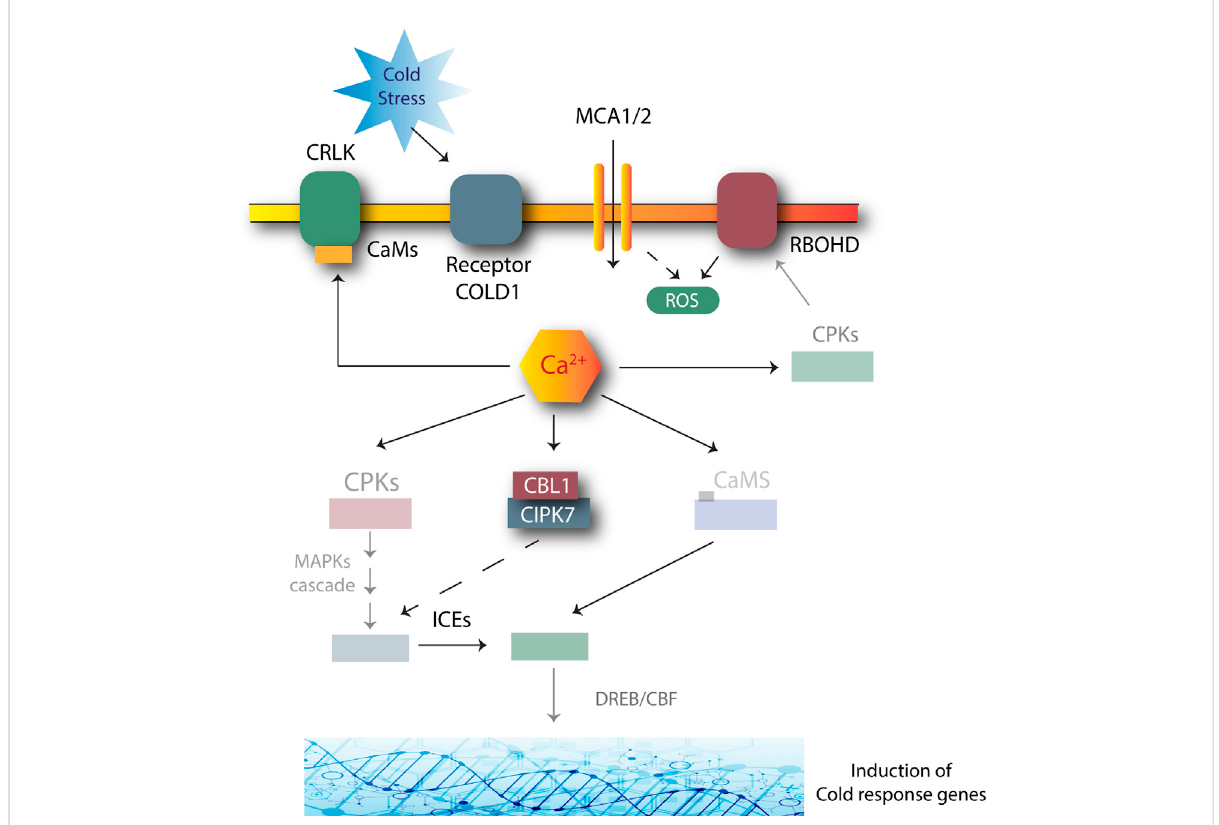
FIGURE 3 Role of CIPK-CBL complexes in managing cold stress in Arabidopsis. Many genes are involved in this response. Cold stress is fi rst perceived by COLD1 receptors. The signals activate the secondary Ca 2+ messengers. The transient changes produced in a cell due to Ca 2+ activation and AtSRC2 produce ROS due to the NADPH oxidase activity of the AtRBOHF. Increased ROS production positively regulates the Ca 2+ channels. CBL1- CIPK playsarolebyphosphorylating andactivating theMAPK cascades. CRLK1 orCRLK2interactswith calmodulin (CaM) tofurtheractivate the MAPK cascade. The MAPK pathway suppresses the breakdown of ICE1 to tolerate stress. Dashed lines: unclear mechanisms; solid lines: induction.